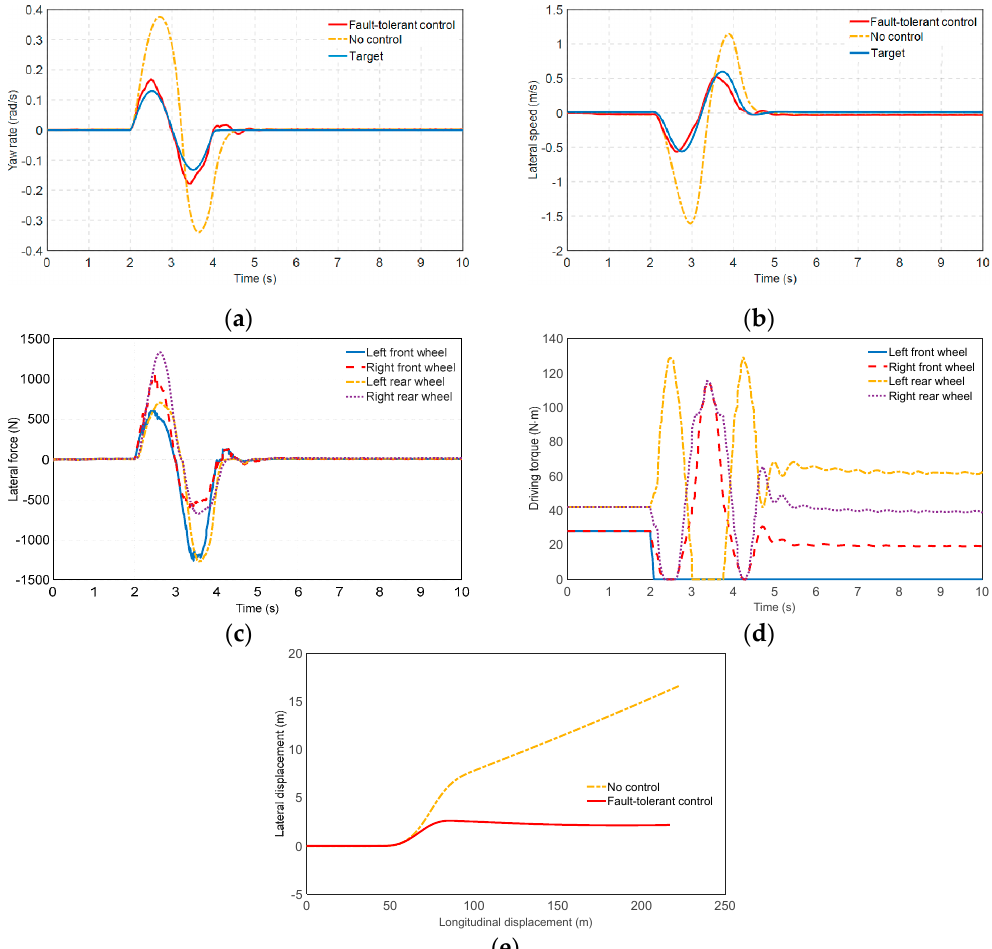
Figure 9. Results of the single failed wheel in sinusoidal steering: ( a ) Yaw rate; ( b ) Lateral speed; ( c ) Lateral force; ( d ) Drive torque; ( e ) Motion trajectory.